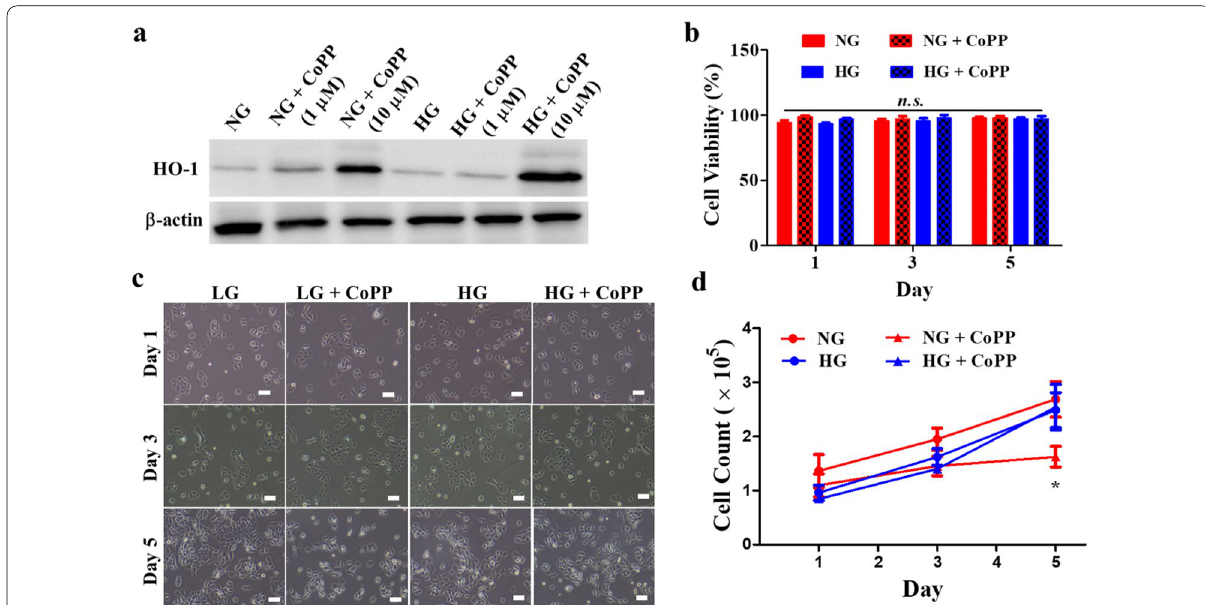
Fig. 2 Proliferation of HaCaT culturedin the presence of CoPP. a Western blotting analysis of HO‑1 in HaCaT cultured in either NG or HG media, after exposing to 1 µM or 10 µM of CoPP. b The effect of 10 µM of CoPP on the viability of HaCaT cultured in either NG or HG media. c The effect of 10 µM of on the morphology of HaCaT throughout the 5 days of exposure in either NG or HG media (scale bar, 100 μm). d Statistical analysis of numbers of HaCaT cultured in either CoPP‑containing NG or HG media. * P < 0.05; n.s. not